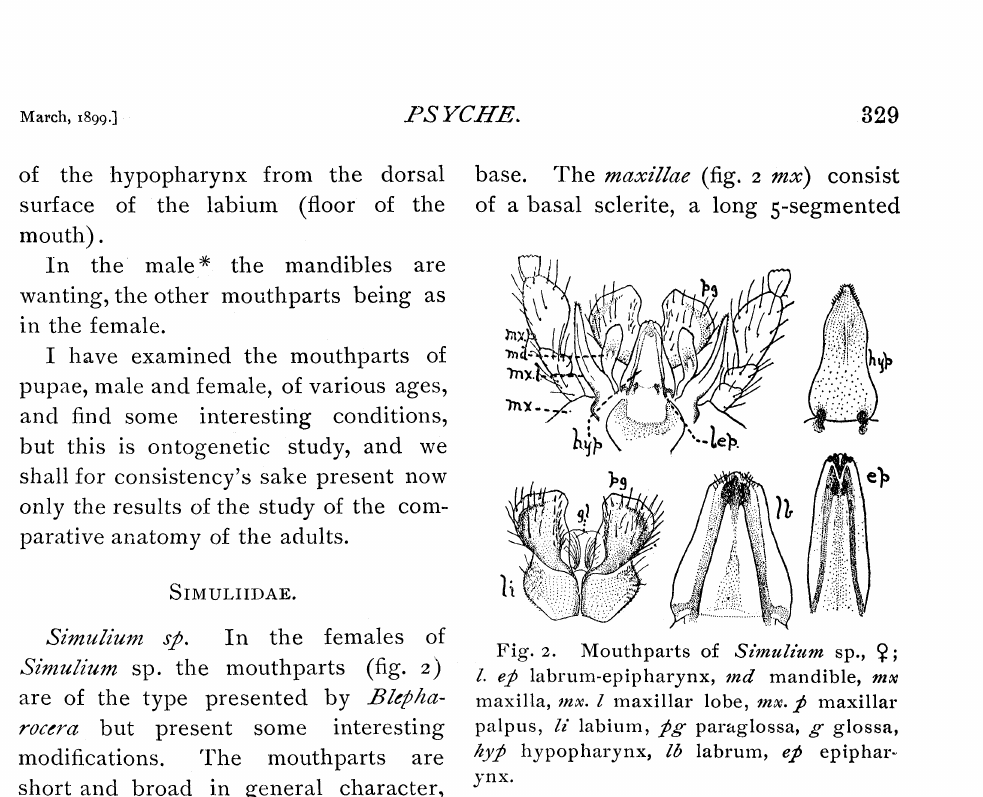
Sienuliuen sp. the mouthparts (fig. 2)